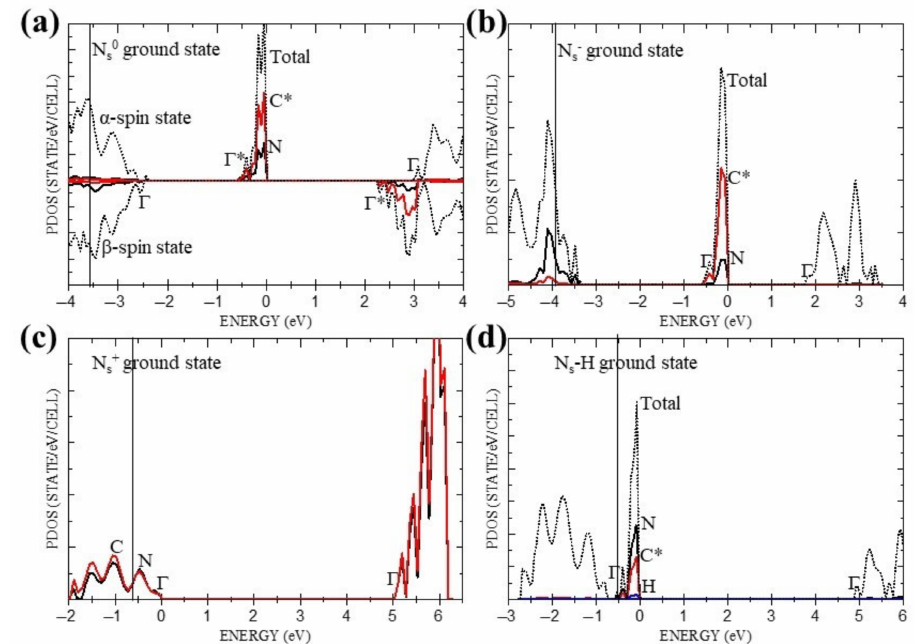
Figure 2. Ground states PDOS for all four systems: ( a ) N s0 , ( b ) N s − , ( c ) N s+ , ( d ) N s -H. Red solid, black solid, blue solid and black dotted lines correspond to carbon*, nitrogen, hydrogen and total DOS, respectively. C* and N refer to Figure 1 and Γ indicates the Γ - points of the individual bands. Vertical solid line indicates a diamond (host) valence band edge.